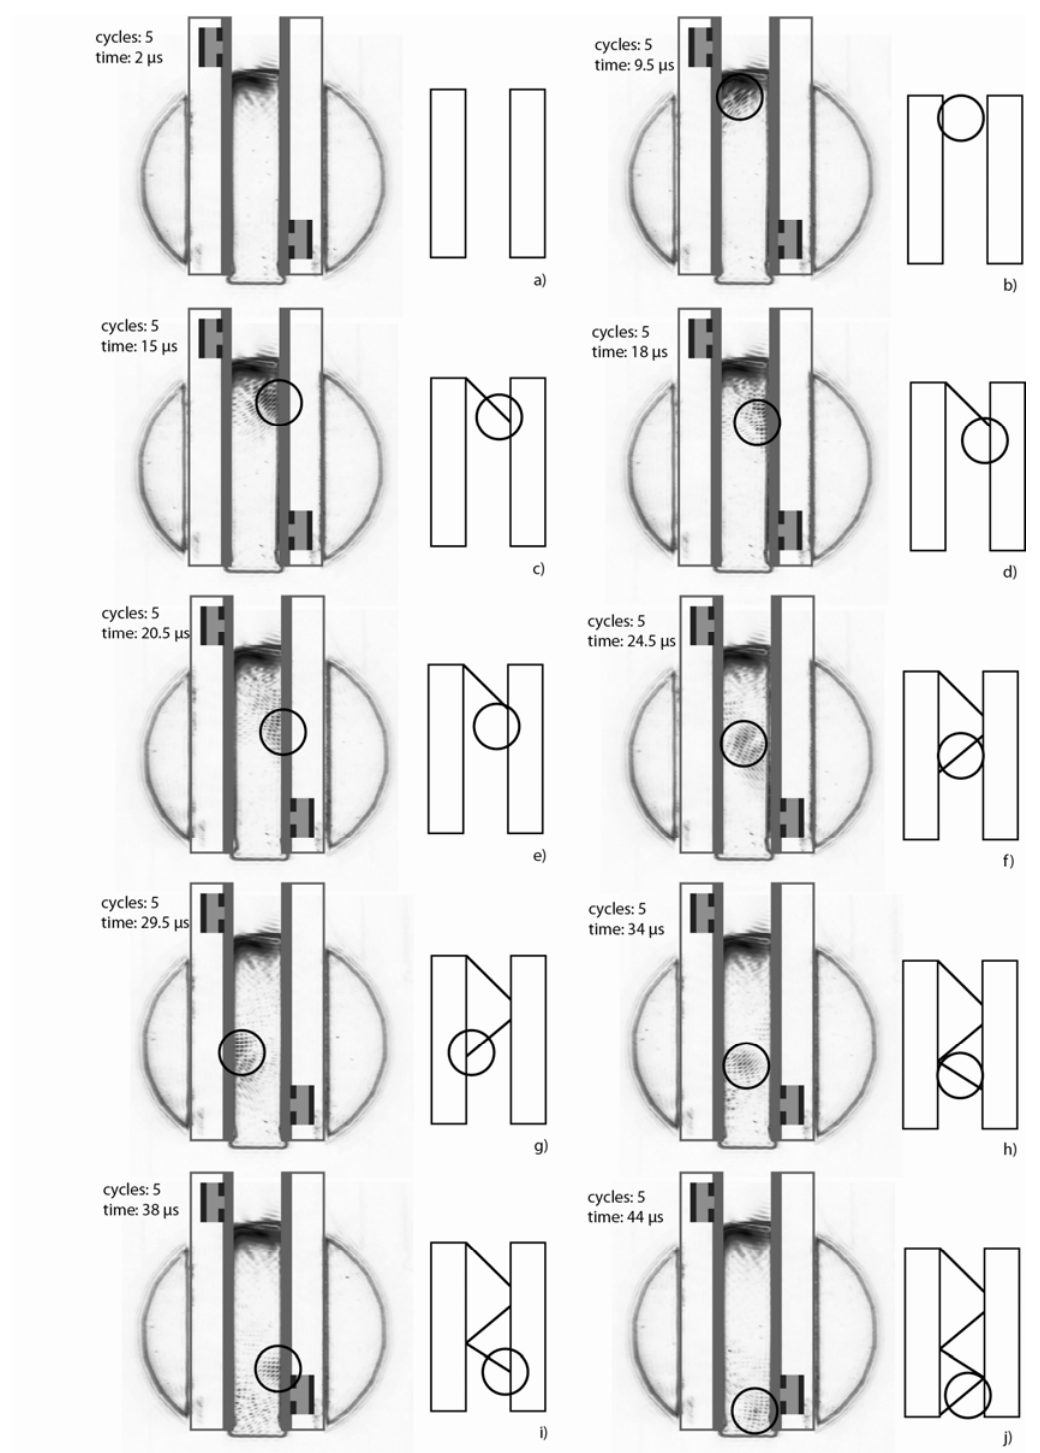
Figure 8. Schlieren images and sketches of sound propagation within the acoustic waveguide by 5 cycles burst excitation of the transmitter. The acoustic wave group is marked by a circle. The recording times are 2 µs ( a ), 9.5 µs ( b ), 15 µs ( c ), 18 µs ( d ), 20.5 µs ( e ), 24.5 µs ( f ), 29.5 µs ( g ), 34 µs ( h ), 38 µs ( i ) and 44 µs ( j ). The location of the transducers and the plates are marked by a